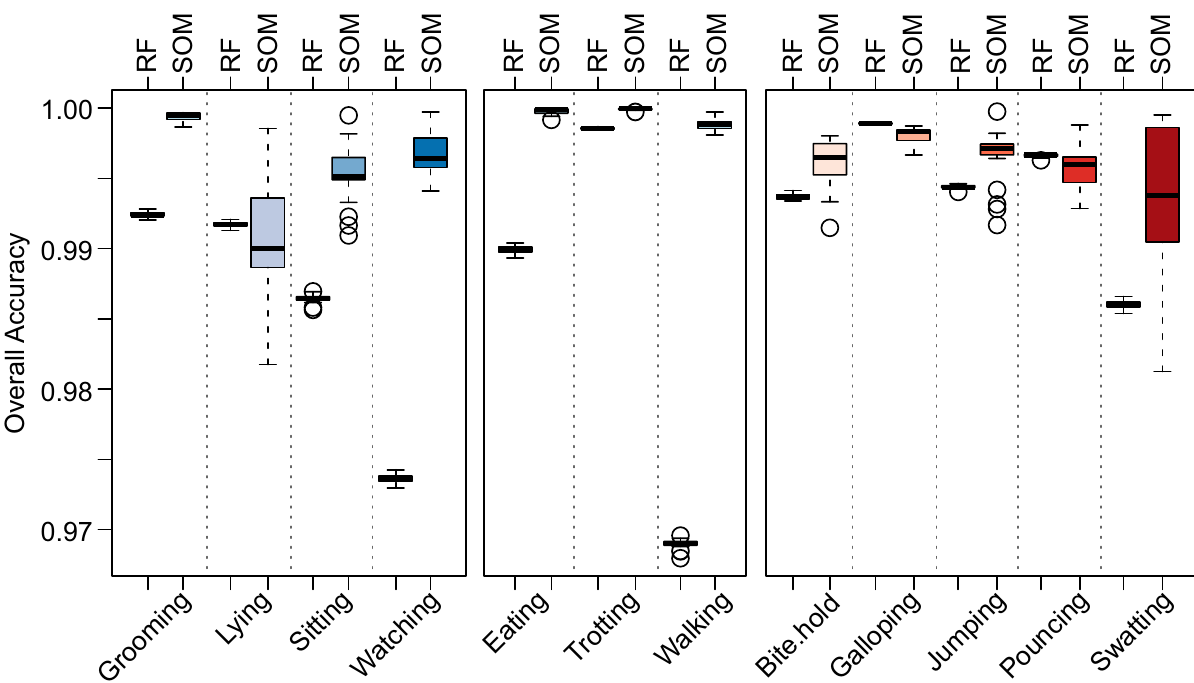
Figure 5. A comparison of the self-organising maps (SOM) procedure with a random forest (RF) classification procedure separated by behaviour. Each procedure was trained with the same random sample of 20,000 1-s epochs of Bib OFF data for all cats to predict the remaining Bib OFF (n = 231,570) samples. Colours represent grouped behaviours, with sedentary activities represented by blue colours, eating and locomotive by green and hunting activities by